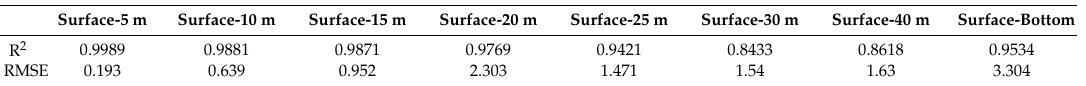
Table 2. Correlation of the fitting relationship between the SSCs of the surface layer and the other layers at the stations in the Bohai Strait.